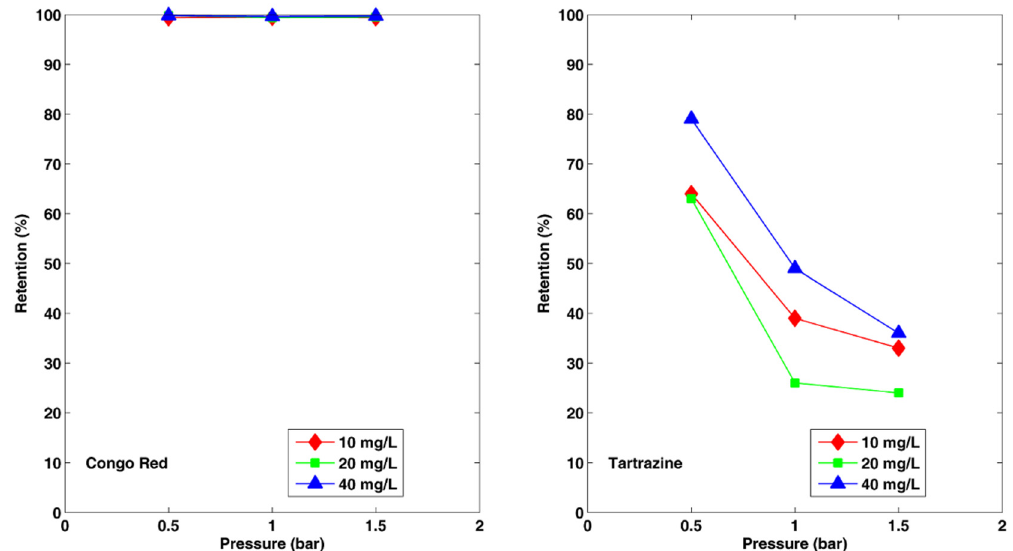
Figure 7. Effect of transmembrane pressure on retention of Congo Red and Tartrazine for the membrane.